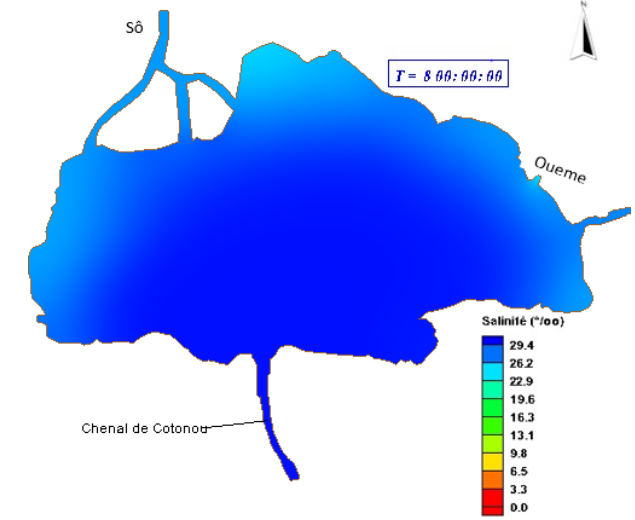
Figure 5. Spatio-temporal variation in salinity – fresh water during the low water period after 8d of simulation.